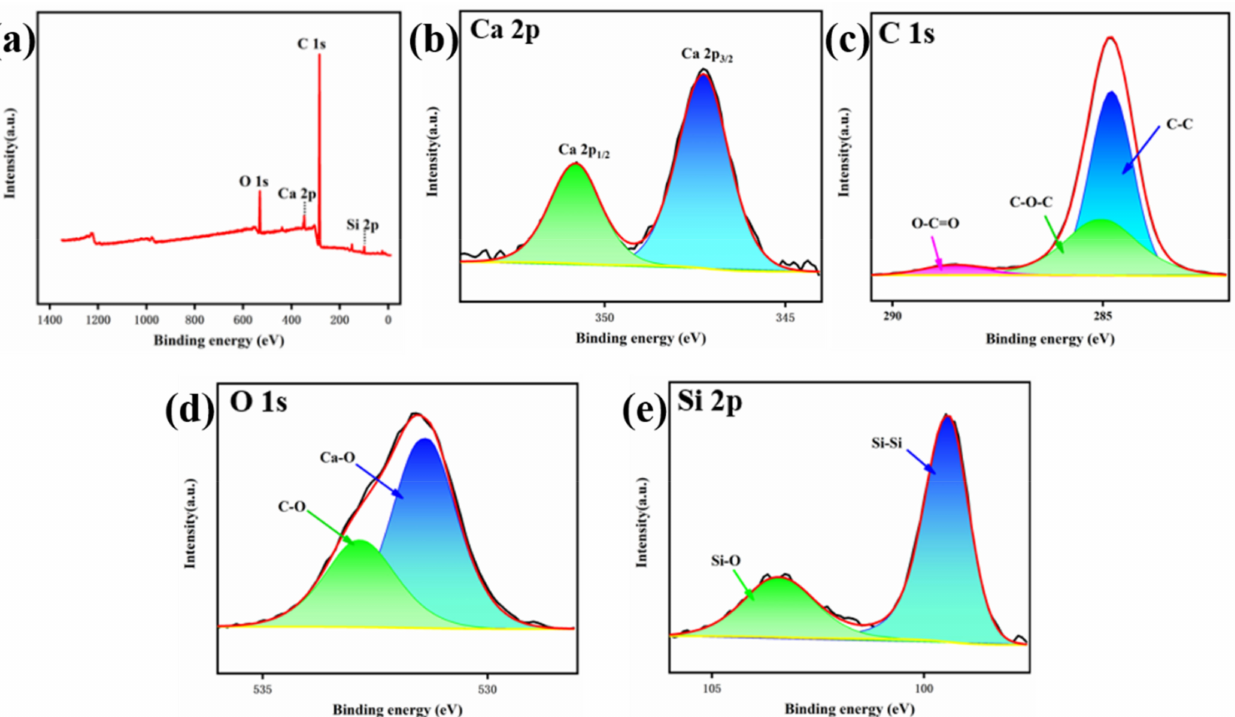
Figure 2. ( a ) Full spectrum of XPS spectrum with white spot stain, ( b – e ) are the characteristic absorption spectra of Ca2p, C1s, O1s and